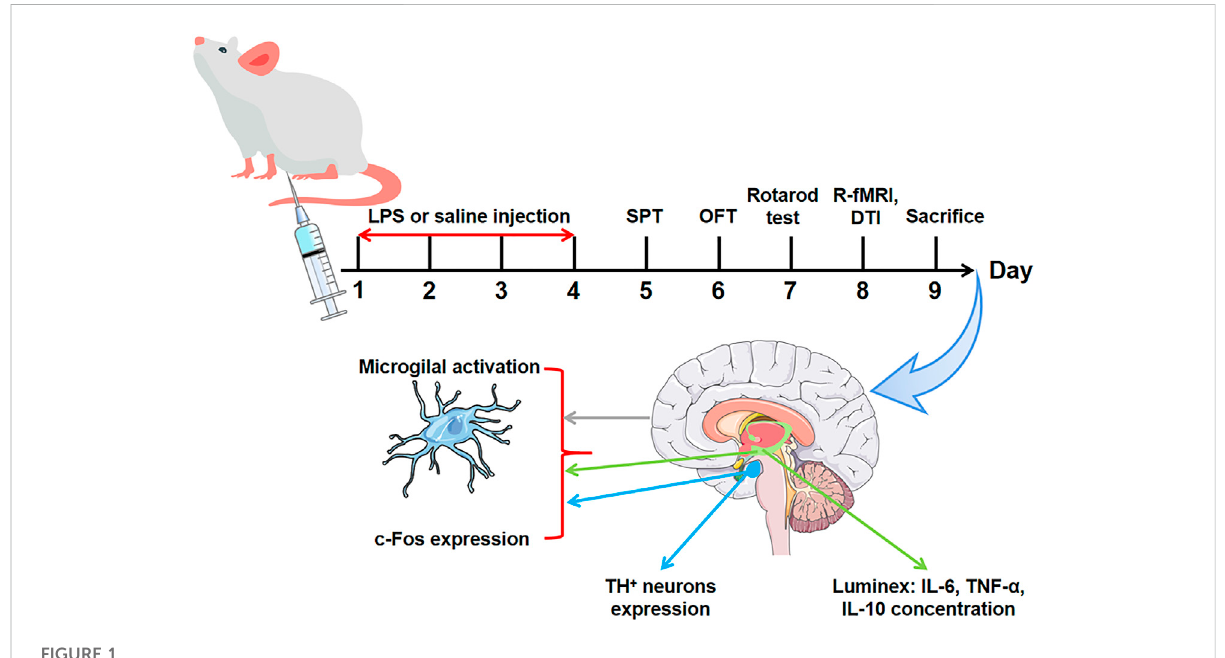
FIGURE 1 Experimental fl ow